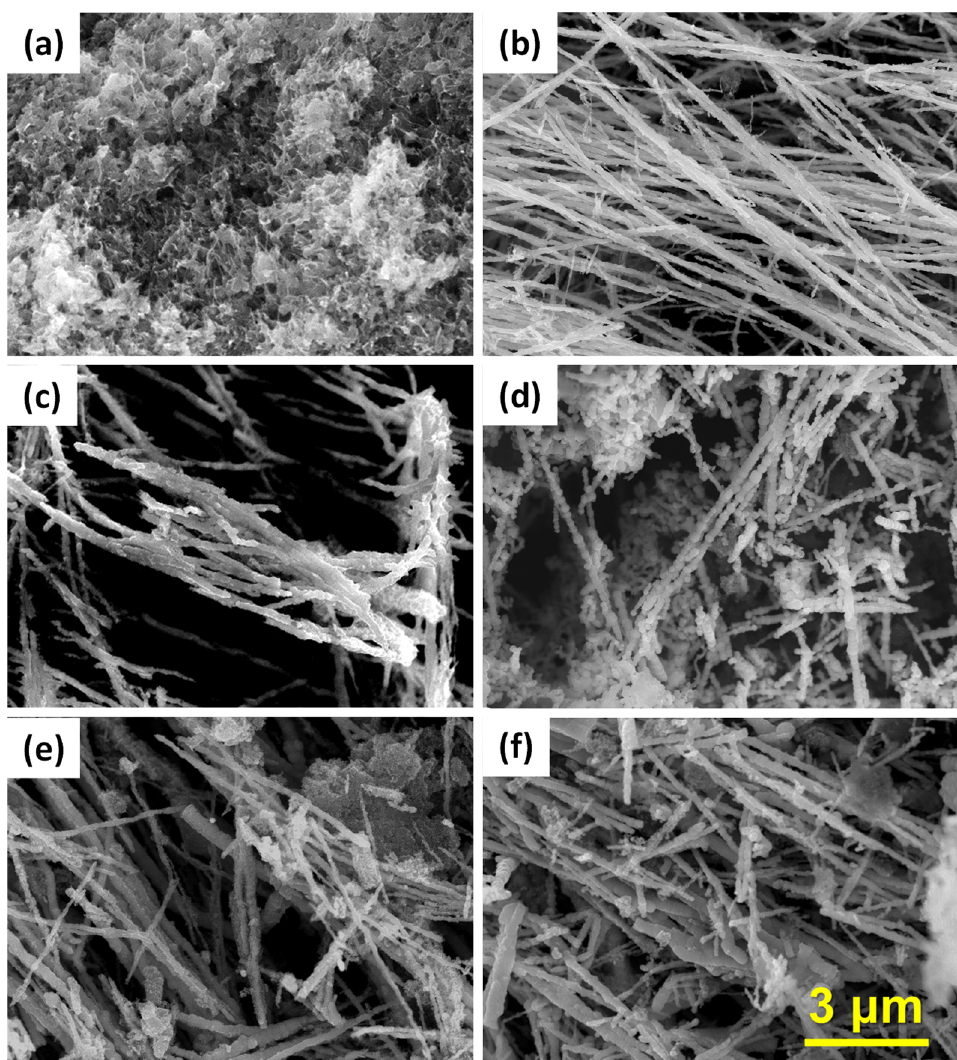
Figure 2. FE-SEM images of ( a ) PANI, ( b ) Fe nanowires, and Fe@PANI in different PANI weight percentages ( c ) 5wt%, ( d ) 10wt%, ( e ) 20wt%, and ( f ) 30wt%. percentages ( c ) 5wt%, ( d ) 10wt%, ( e ) 20wt%, and ( f )